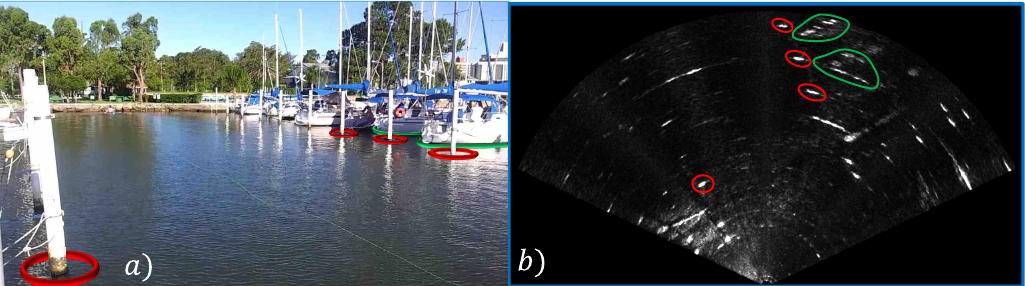
Figure 1. An example of a semantic information that can be extracted from acoustic images collected on a harbor. ( a ) the water surface image with the associated objects; ( b ) the sonar data acquired by an Forward Looking Sonar (FLS) and the segmented areas using colors. We show the same poles in red and the same hulls in green in both images. The acoustic returns that are not highlighted represent structures of the harbor that do not have a vision intersection between the optical and acoustic images.